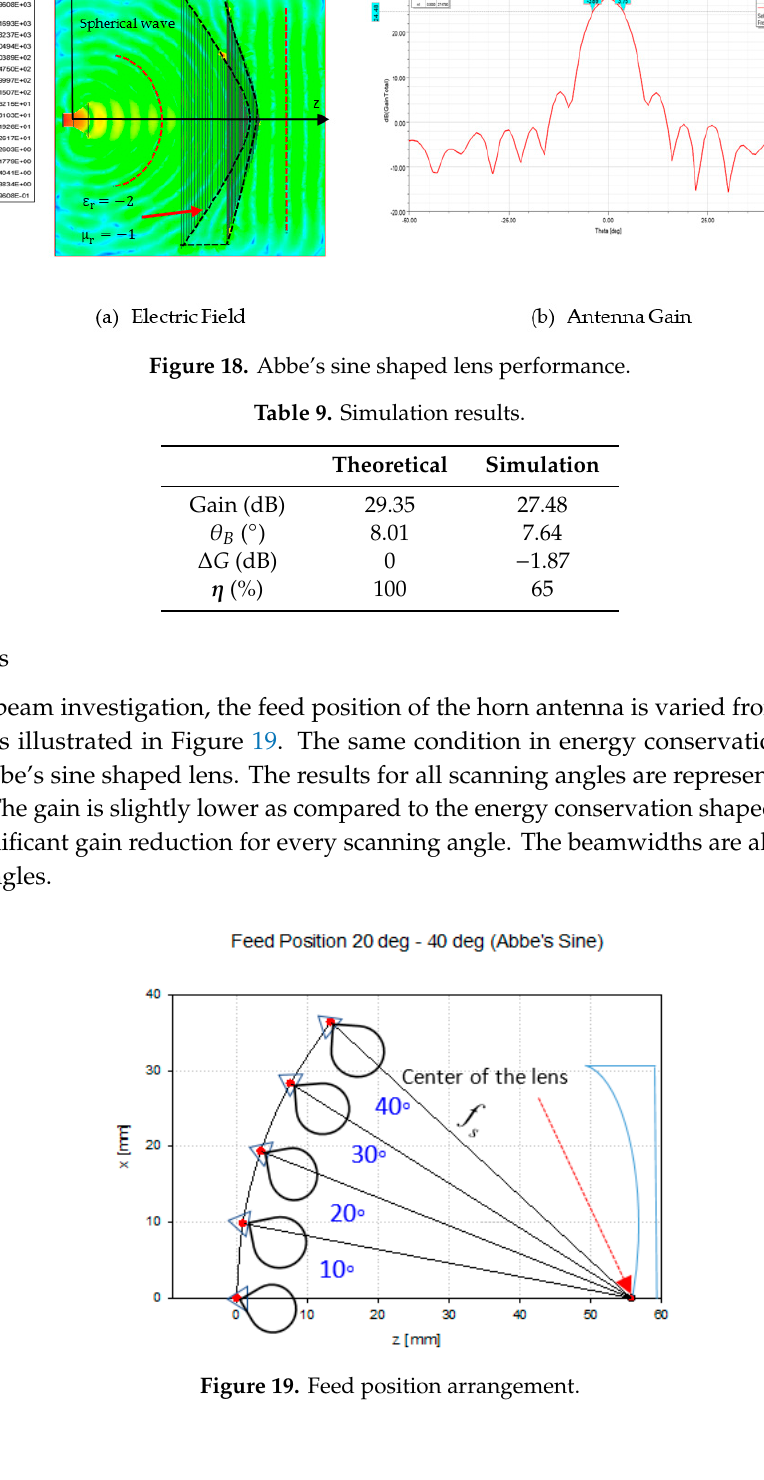
Figure 20. Antenna gain for scanning angle 0° to 40° . Table 10. Simulation results of different feed positions. 𝜽 ( ° )